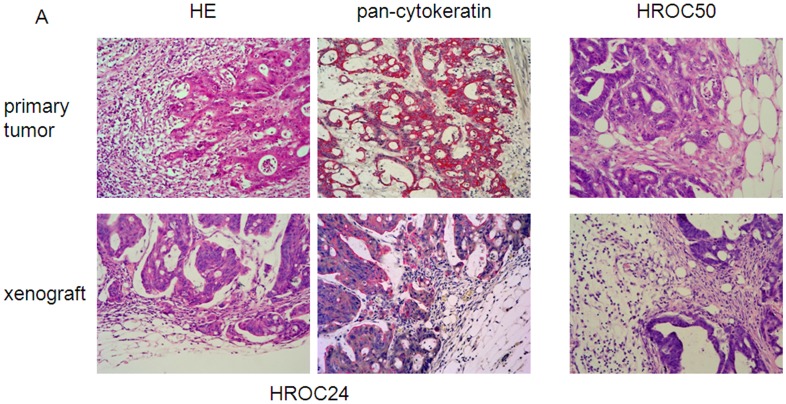
Morphology of primary MMR-D tumors and their corresponding xenografts.HE-histology representing maintenance of HROC24 tumor morphology following xenografting. The pan-cytokeratin staining is strongly positive, consistent with the tumors’ epithelial origin (left upper and lower panel). HE-histology of HROC50 tumors (right upper and lower panel).